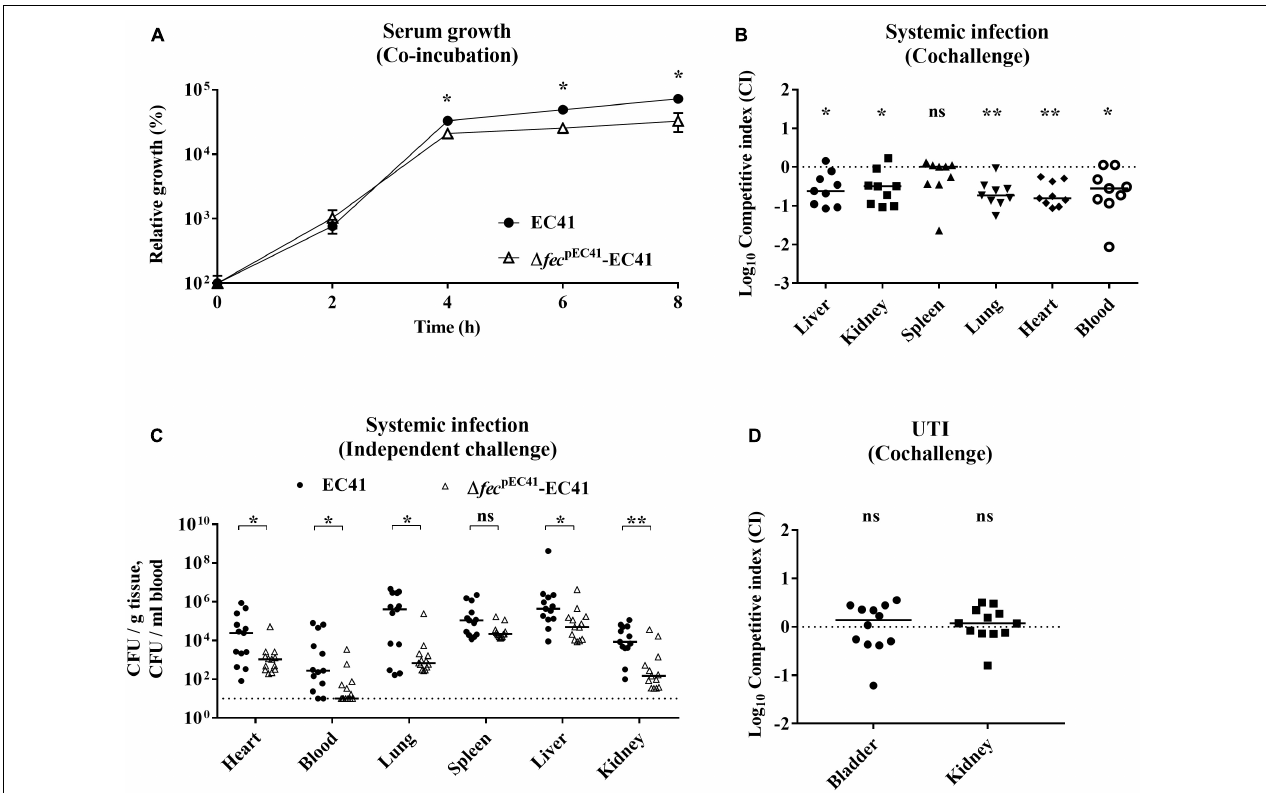
FIGURE 5 | The roles of fec pEC41 in EC41 growth in heat-inactivated serum and in the pathogenesis of systemic infections and urinary tract infections. (A) The growth of EC41 and (cid:49) fec pEC41 -EC41 cocultured in 90% heat-inactivated mouse serum. The results are presented as the means ± SD. The data are shown as the relative growth rates compared to the bacterial counts of the original inoculums. The data are representative of three independent experiments performed in triplicate. (B) Cochallenge of EC41 and (cid:49) fec pEC41 -EC41 in a mouse model of systemic infection. Equal numbers of EC41 and (cid:49) fec pEC41 -EC41 were coinoculated into BALB/c mice via the tail vein ( N = 9). At 24 h postinfection, the bacterial numbers of each strain in the liver, kidney, spleen, lung, heart, and blood were determined, and the competitive indices (CI) of (cid:49) fec pEC41 -EC41 vs. EC41 in these tissues were calculated. (C) Independent challenge with EC41 and (cid:49) fec pEC41 -EC41 in the mouse model of systemic infection. The bacterial counts in the organs and blood were determined at 24 h postinfection. ( N = 13 for the animals infected with each bacterial strain). (D) Cochallenge of EC41 and (cid:49) fec pEC41 -EC41 in a mouse model of UTIs. Equal numbers of the two strains were transurethrally coinoculated into female C3H/HeN mice ( N = 12). At 24 h postinfection, the bacterial counts and the CI of (cid:49) fec pEC41 -EC41 vs. EC41 in bladders and kidneys were determined. The horizontal bars indicate median values. For (C) , the dashed line represents the detection limit. For (B,D) , the dashed lines represent the log 10 scale of CI = 1. The CI in the cochallenge experiments was calculated using bacterial counts with the equation [( (cid:49) fec pEC41 -EC41 CFU/EC41 CFU) output /( (cid:49) fec pEC41 -EC41 CFU/ (cid:49) fec pEC41 -EC41 CFU) input ]. The log 10 scale of CI values less than 0 (CI = 1) indicates a comparative defect in (cid:49) fec pEC41 -EC41. The paired two-tailed student’s t test and The Mann–Whitney U test was used for the statistical analyses of (A,C) . The Wilcoxon signed-rank test was used in (B,D) . * P < 0.05, ** P < 0.01; ns, no significant difference. TABLE 2 | Distribution of fecA in different source groups of E. coli isolates. No. (%) of E. coli isolates P- value a Gene Fecal isolates Cystitis isolates Pyelonephritis Bacteremia Fecal vs. cystitis Fecal vs. Fecal vs. ( N = 87) ( N = 67) isolates ( N = 72) isolates ( N = 43) isolates pyelonephritis bacteremia isolates isolates